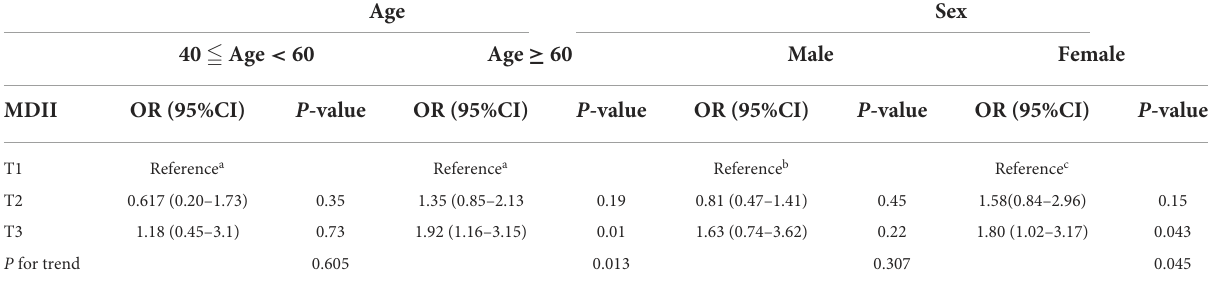
TABLE 4 Multivariate logistic model for OP risk stratified by age and